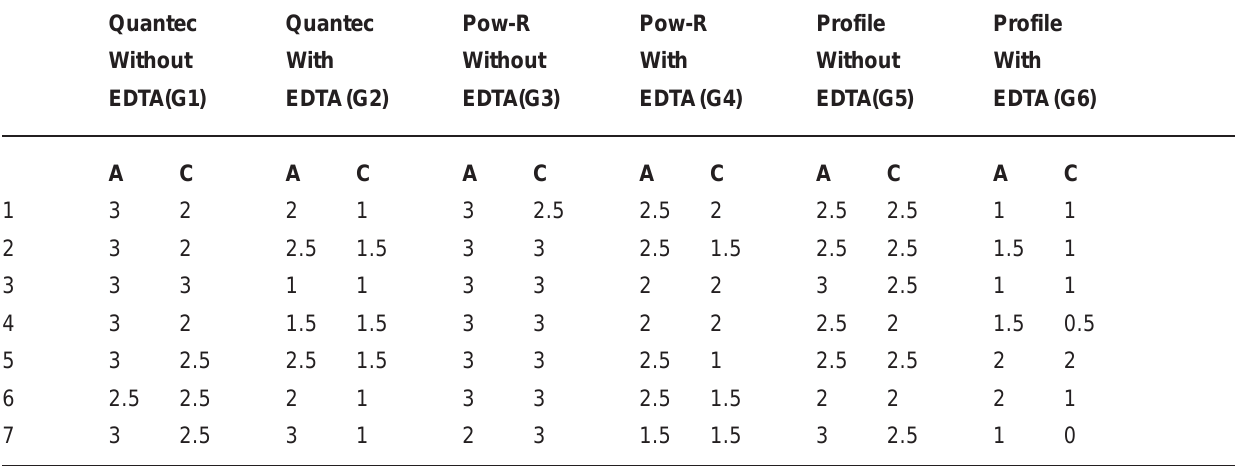
TABLE 1- Scores attributed to the apical (A) and cervical (C) third